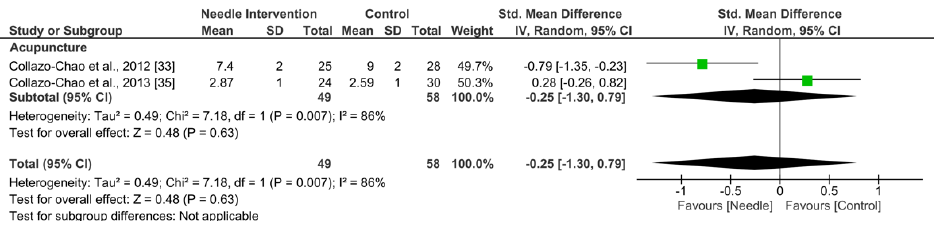
Figure 9. Forest plot for Sleeping Quality after 3 – 6 months.